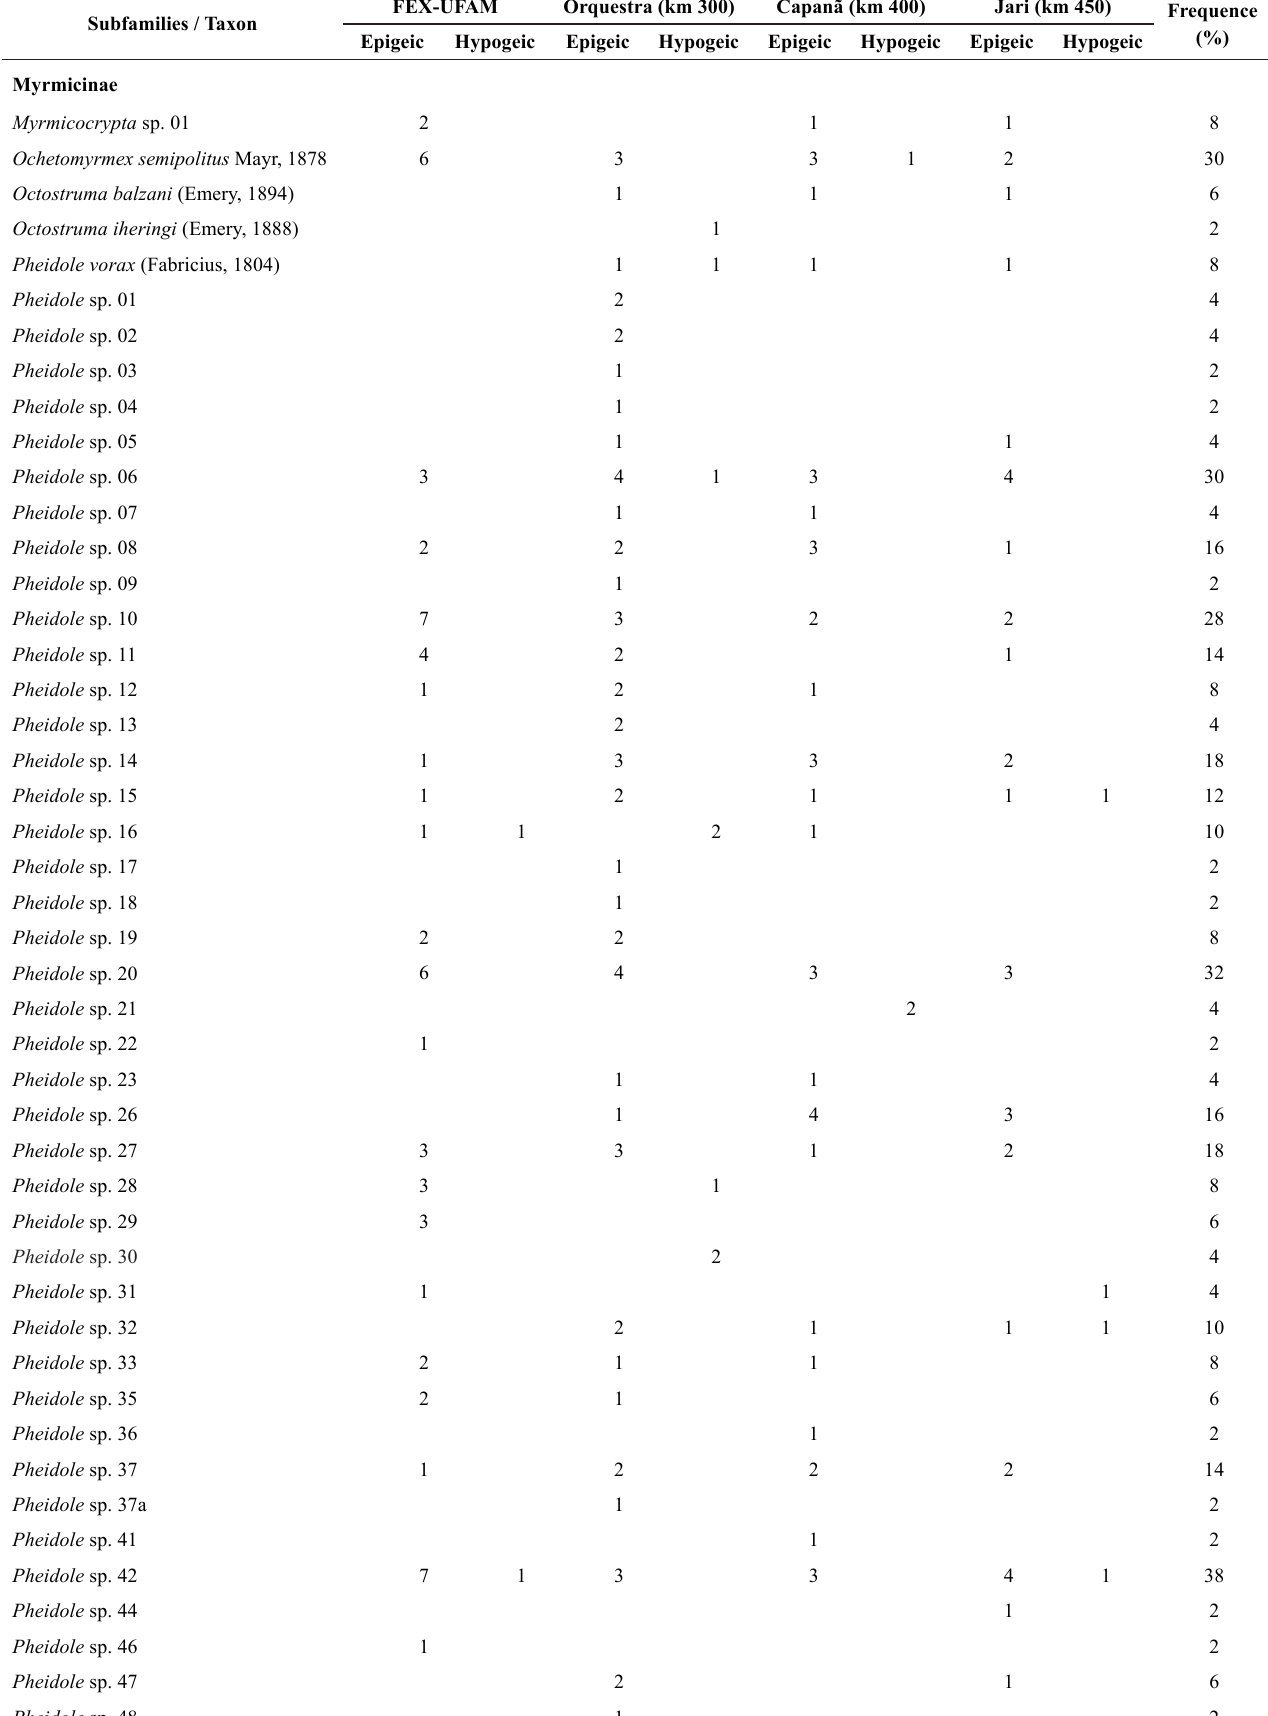
Table 2 . Occurrence and frequency of ant species and morphospecies sampled in the hypogeic (10 plots) and epigeic (7 plots) strata at UFAM and on BR 319 modules Orquestra, Capanã and Jari (5 plots in both strata for each site).